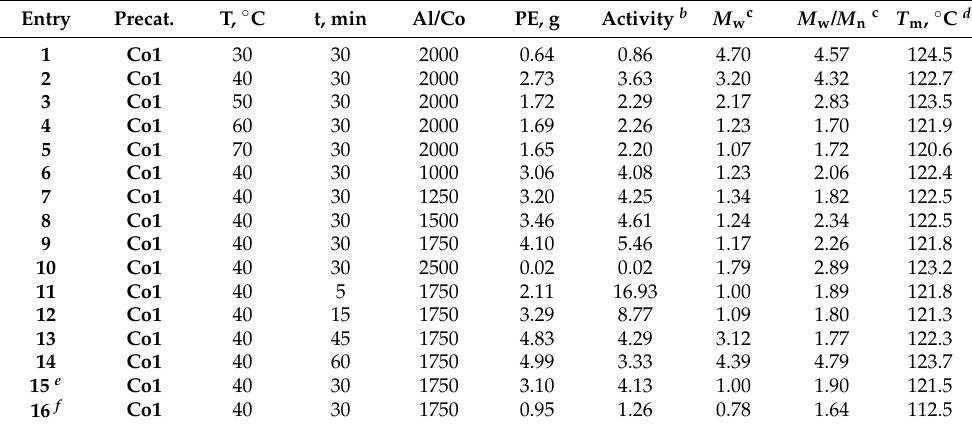
Table 3. Ethylene Polymerization by Co1 /MMAO under the conditions a .